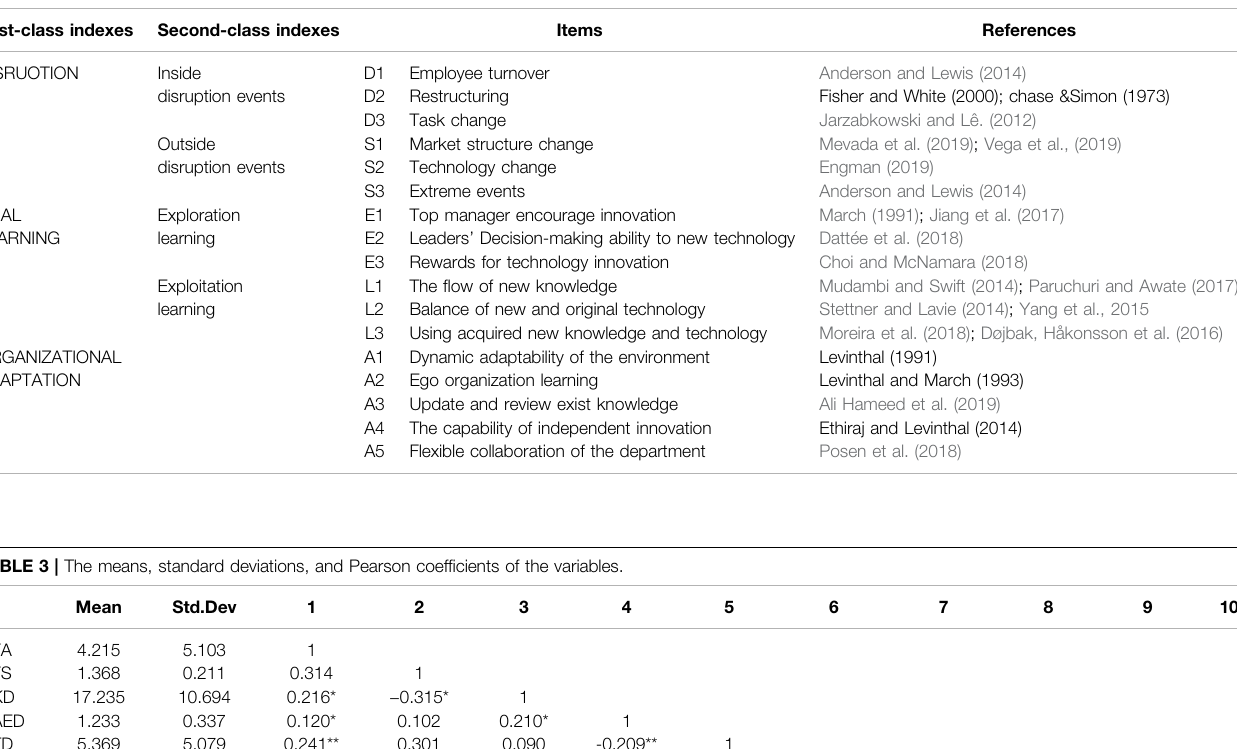
TABLE 2 | Each index measures item in detail.